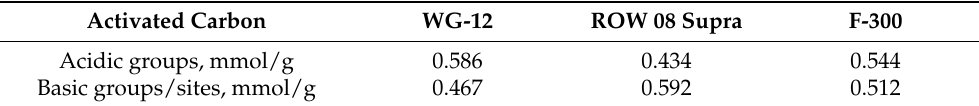
Table 9. The amount of acidic and basic groups on activated carbons WG-12, F-300 and